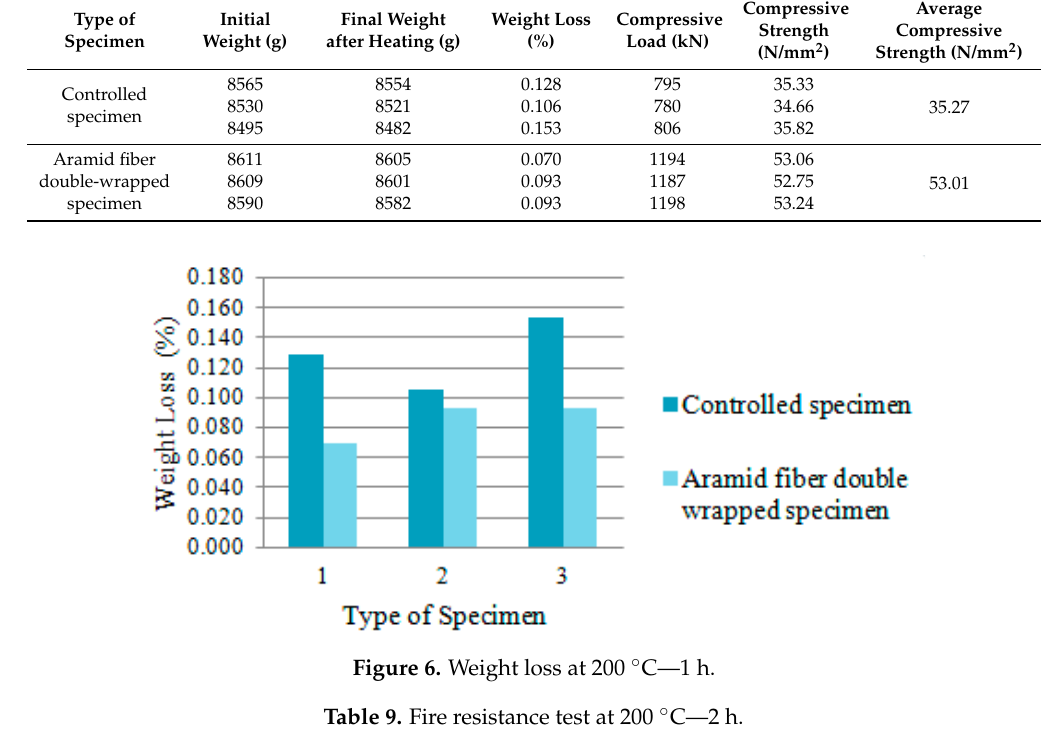
Figure 5. Fire resistance test. Table 8. Fire resistance test at 200 ◦ C—1 h.